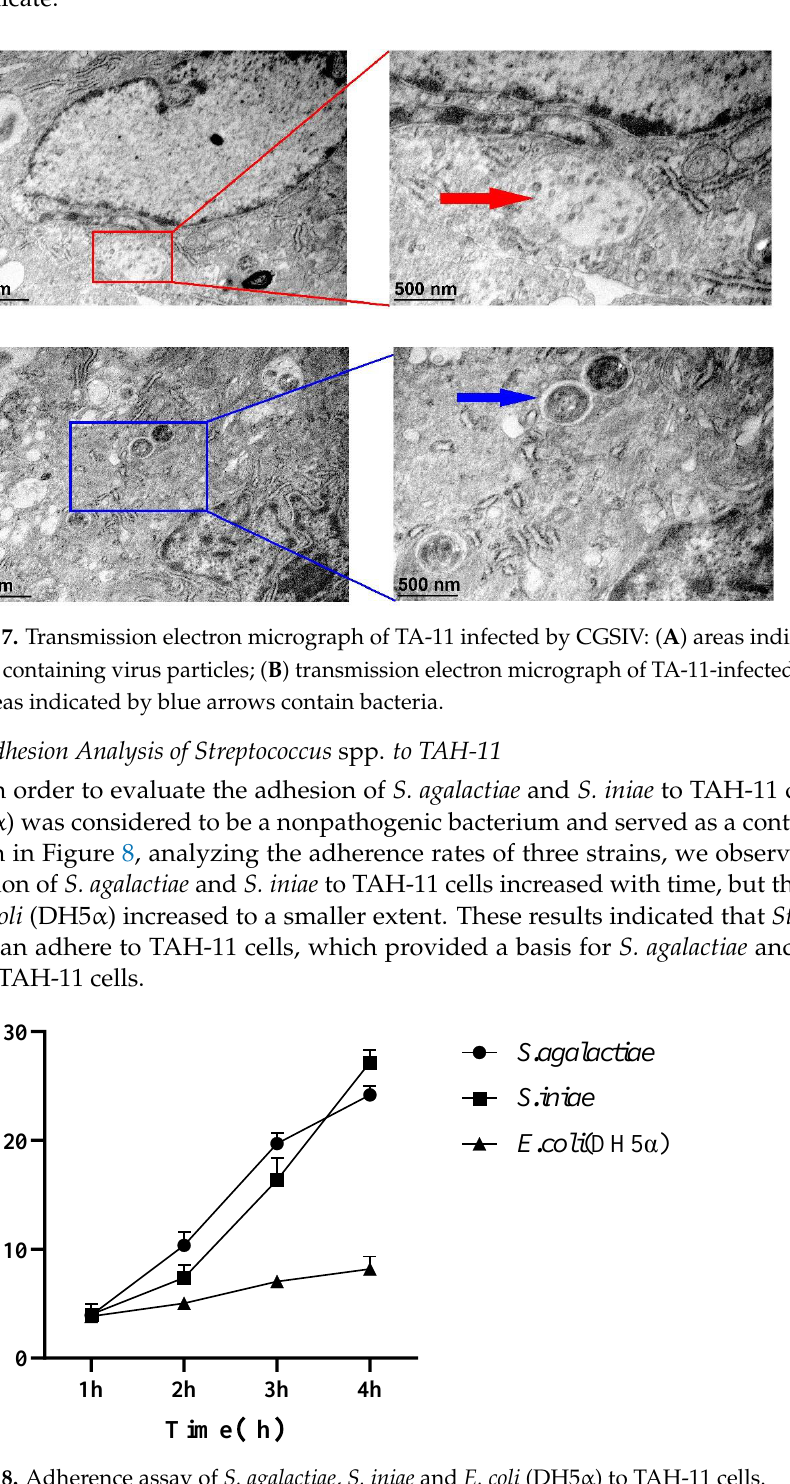
Figure 8. Adherence assay of S. agalactiae , S. iniae and E. coli (DH5α) to TAH-11 cells.